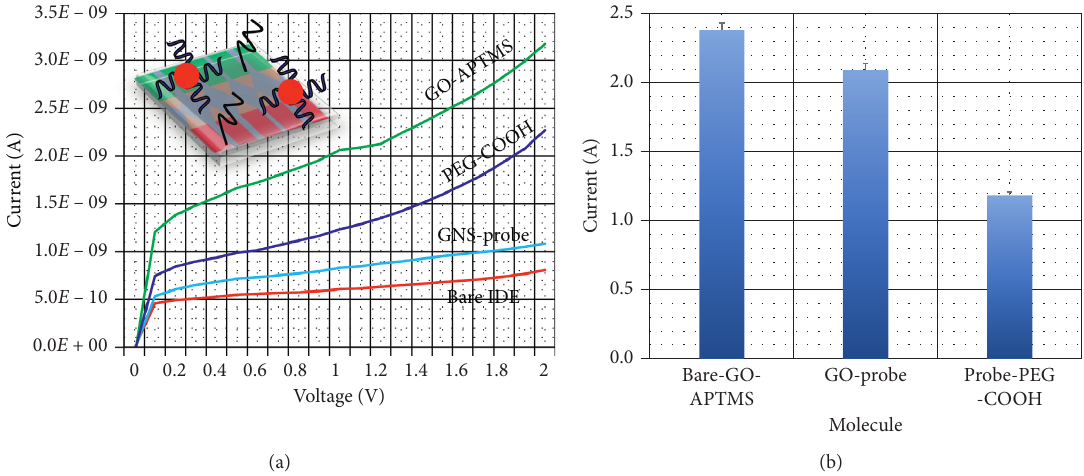
Figure 2: (a) Process and current response of GNS-probe immobilization. After probe immobilization, clear changes in current were noted. Coloured lines are GO-APTMS (green), PEG-COOH (blue), GNS-probe (sky blue), and bare IDE (red). (b) Difference in current change GNS-probe immobilization. Probe attachment shows the highest difference in